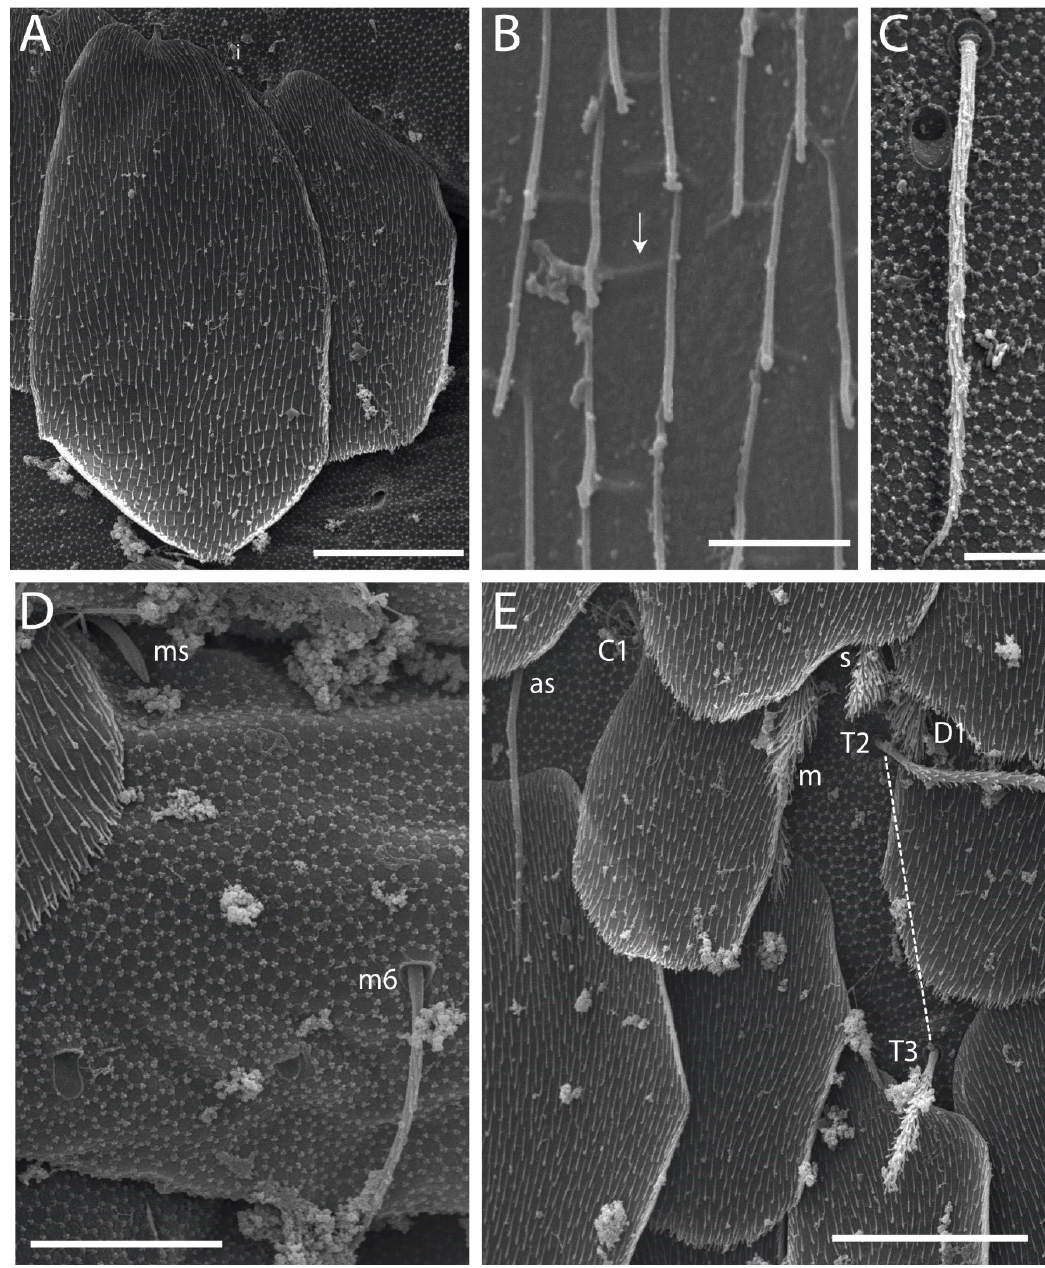
Figure 4. Pseudosinella spp.: SEM of thorax and abdomen. ( A ) Tergal scales; ( B ) scale part, with the arrow indicating interciliary connection; ( C ) ciliate mic on Th II; ( D ) Abd I lateral area (right side), where ms is sens and m6 is mic; ( E ) Abd IV area (right side), as elongated sens, C1 mac, T2 bothriotrichum, T3 ciliate mic, and D1, with m and s fan-shape accessory chaetae. Scale bars: 0.01 mm ( A , E ), 0.001 mm ( B ), 0.002 mm ( C ), and 0.005 mm ( D ).